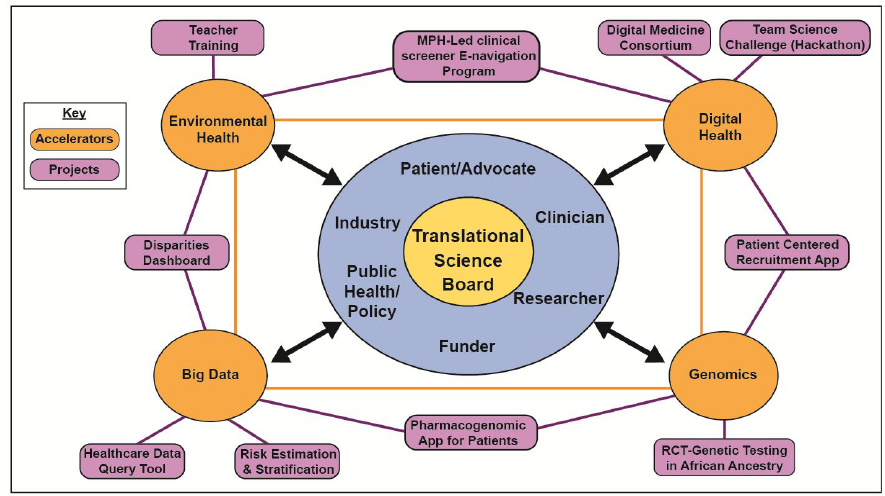
Figure 2. Overview of the Translational Science Board and accelerators.